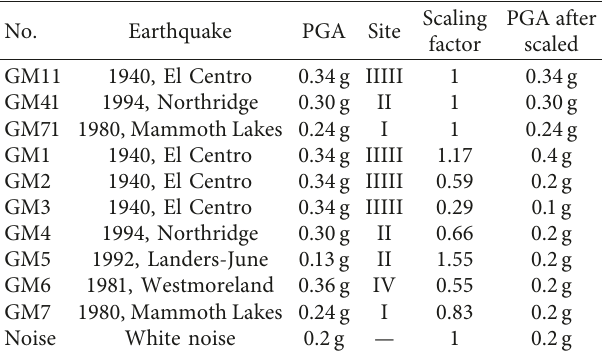
Table 1: Ground motion records for time-history